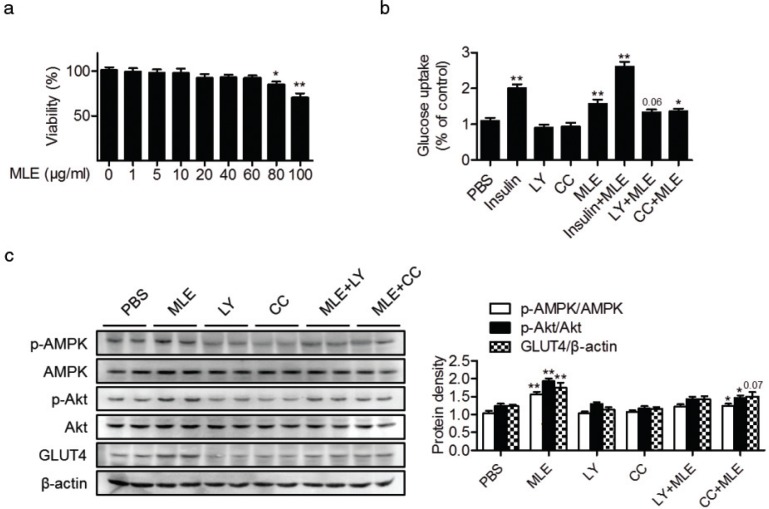
Effects of MLE on glucose uptake in L6 myotubes. (a) L6 myotubes were treated with the indicated concentrations of MLE, and cell viability was determined by MTT assay (n = 5). (b) L6 myotubes were treated with MLE (60 μg/mL), 0.1 μM insulin, 25 μM LY294002 (LY), or 10 μM compound C (CC) as indicated. After 6 h, [3H]2DOG uptake was measured (n = 7/each group). (c) L6 myotubes were treated with MLE (60 μg/mL), 25 μM LY294002, or 10 μM compound C (CC) for 5 min, and protein levels of p-Akt, Akt, p-AMPK, AMPK, and GLUT4 were analyzed by western blotting. The band intensities of each protein were quantitated (n = 5). Values are expressed as mean±SEM. MLE, mulberry leaf extract; CC, compound C; LY, LY294002.